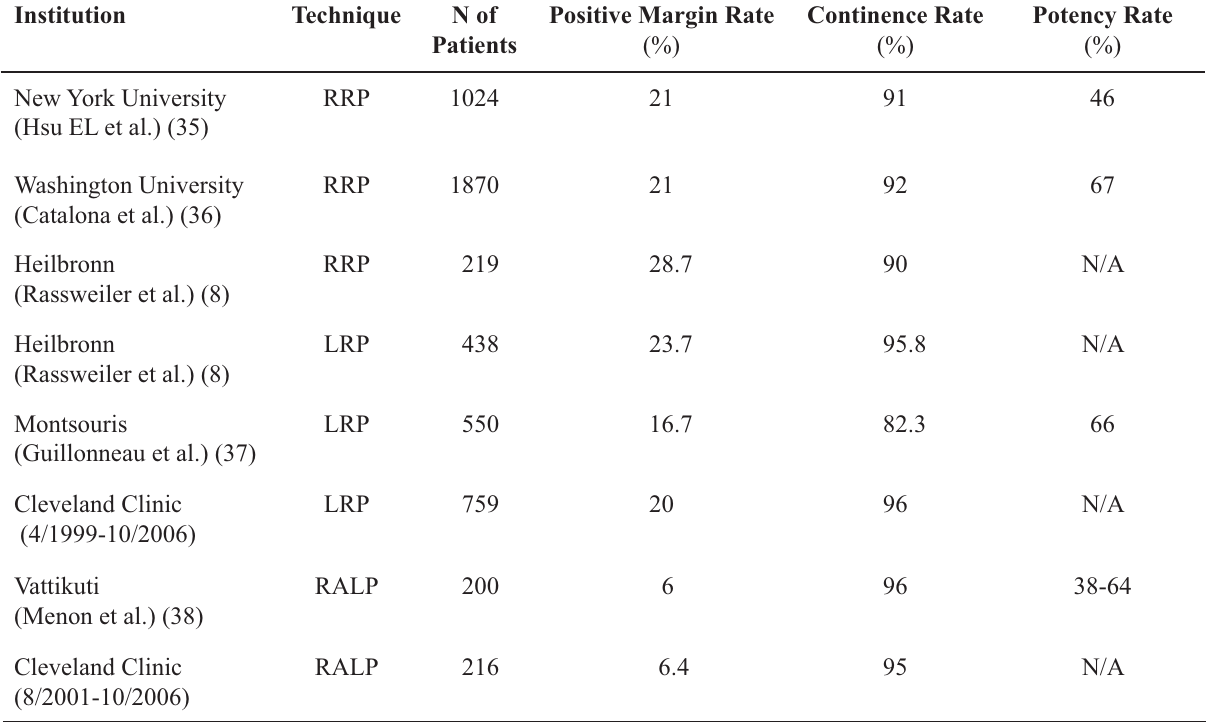
Table 2 – Oncologic and functional outcomes of RRP, LRP and RALP from select